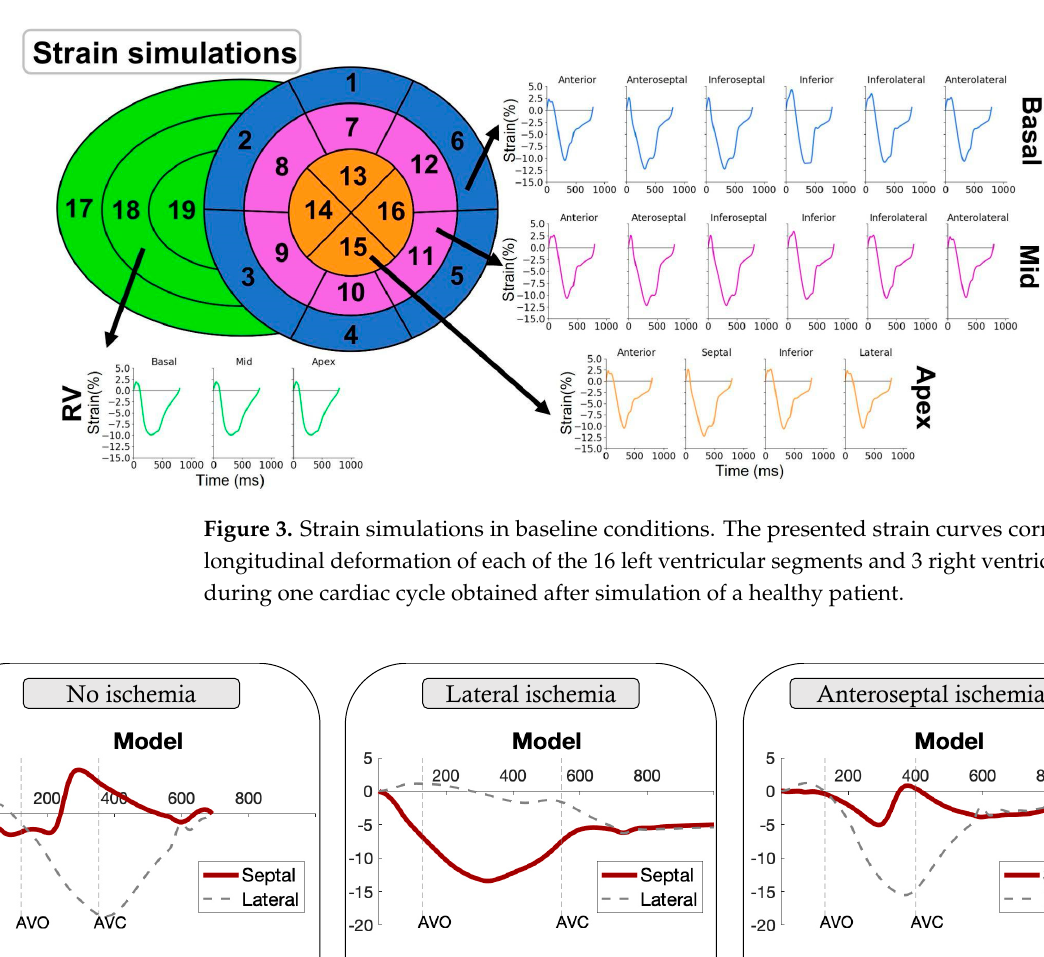
Figure 2. Hemodynamic simulations in baseline conditions.